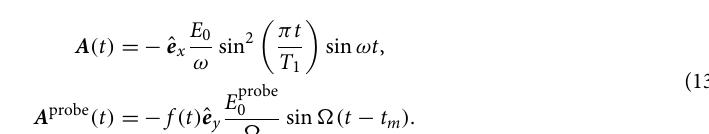
Figure 11. x component of the fundamental IR field ( a ) and y − TDSE calculation. IR field parameters: E 0 (cid:31) 1.5 =